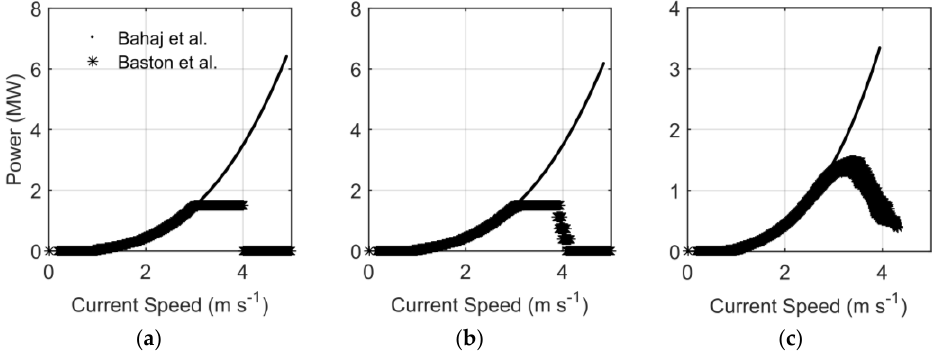
Figure 10. Mean power generated per turbine for the arrays of ( a ) 1; ( b ) 4; and ( c ) 57 turbines. The mean power is plotted against the average velocity at the turbine locations.